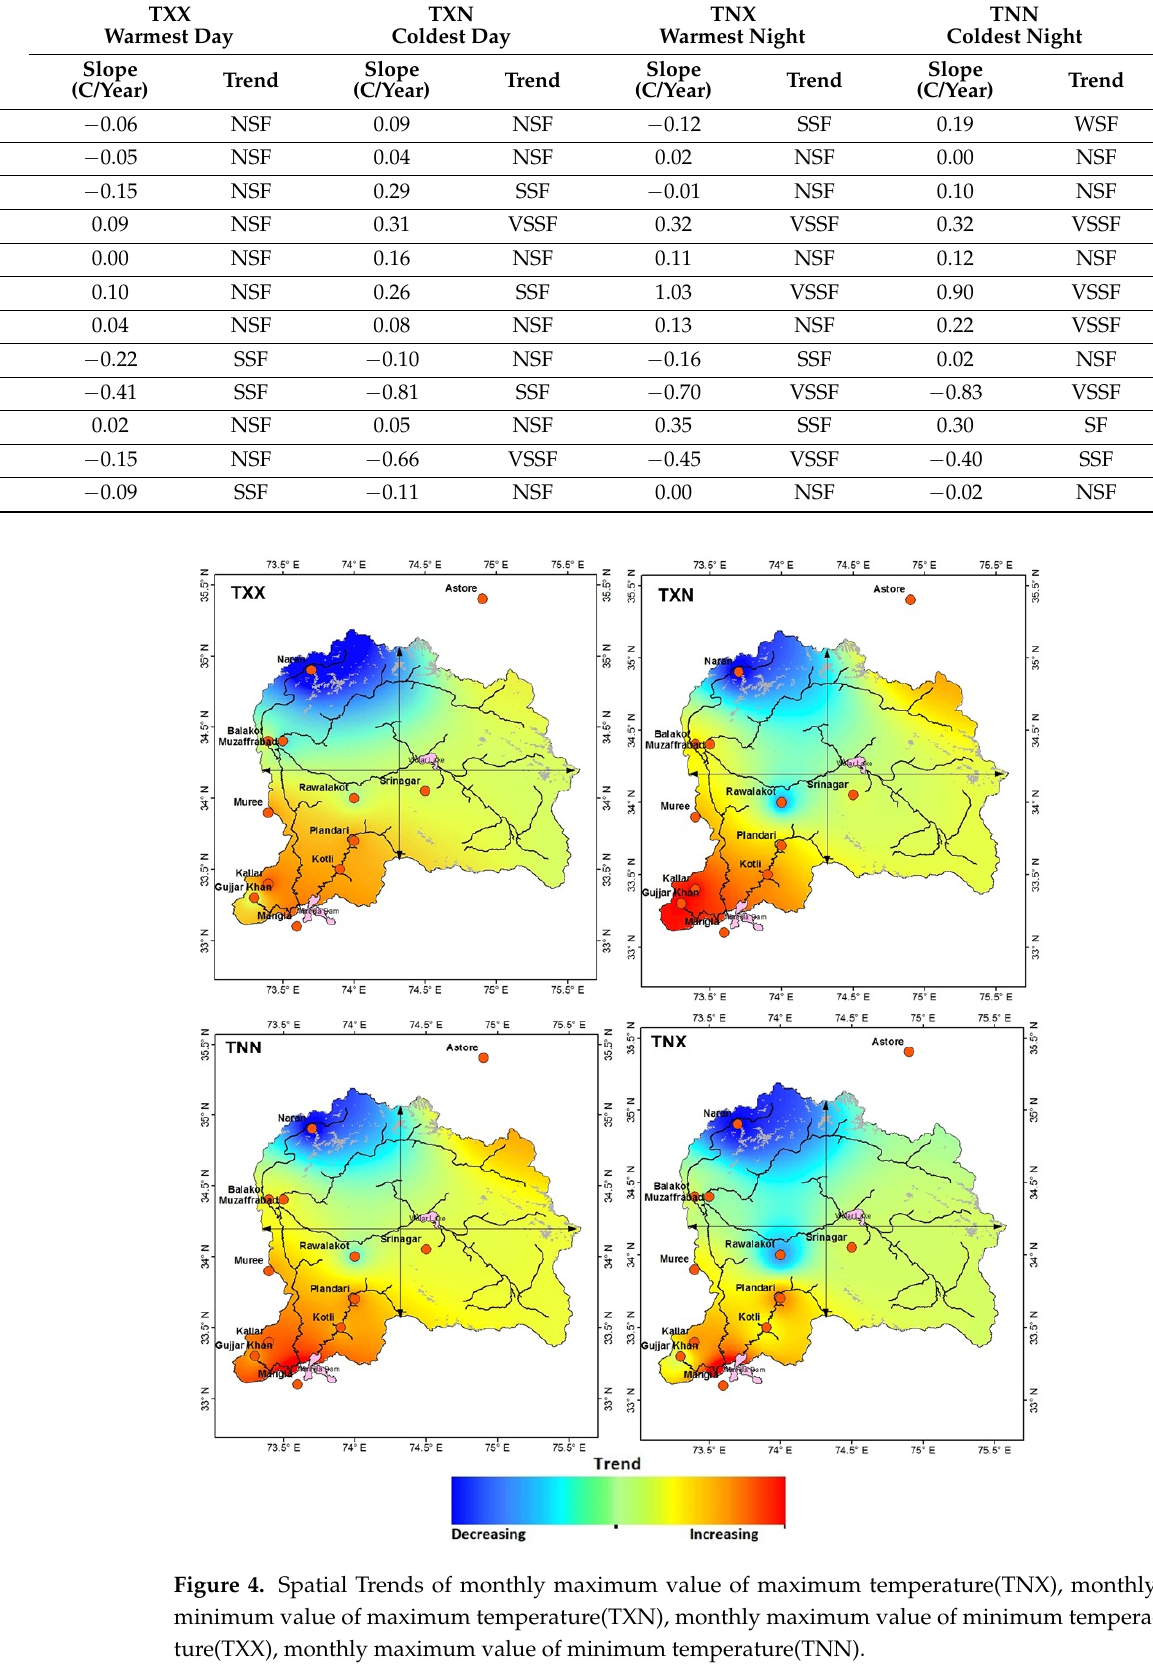
Table 5. Absolute temperature indices slopes and trends.